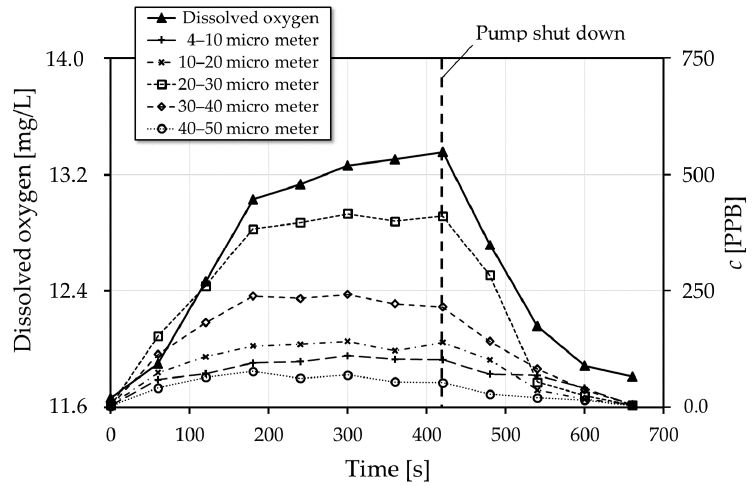
Figure 11. Dissolved oxygen and microbubble concentration in respect to time at the pump pressure of 5 bar and the air flowrate ratio of 4.0 percent.